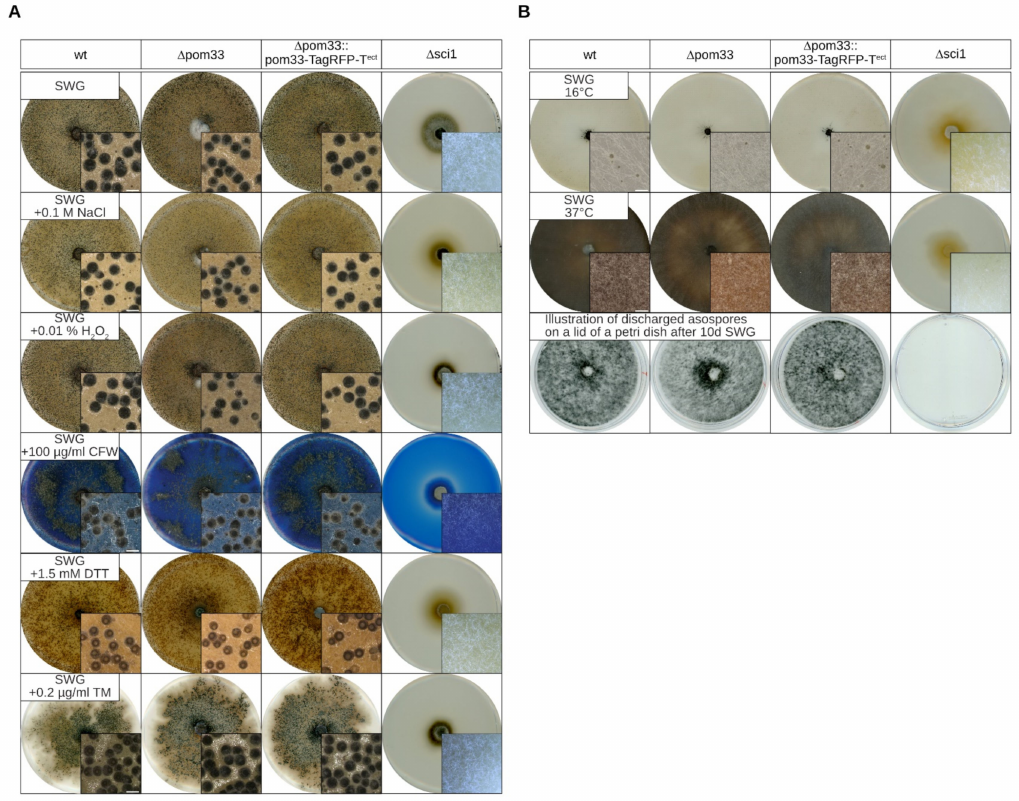
Figure 4. Sexual development in the wt, ∆ pom33, the complementation strain and ∆ sci1 on different stress media. ( A ) The wt, deletion mutant ( ∆ pom33) and the complementation strain ( ∆ pom33::pom33-TagRFP-T ect ) as well as the ∆ sci1 strain were grown in presence of different stress conditions, such as osmotic- (0.1 M NaCl), oxidative- (0.01% H 2 O 2 ), cell wall- (100 µ g/mL CFW), or ER stress (1.5 mM DTT, 0.2 µ g/mL TM) by adding the different components to SWG medium. ( B ) Strains from ( A ) were grown on SWG media at 16 ◦ C and 37 ◦ C to perform temperature stress. After 10 days the lids of petri dishes with discharged ascospores were documented. Here, the spores were already germinated. Pictures of the agar plates and microscopic images of perithecia as shown in the small boxes on the bottom right sides were taken after 8 days. Scale bar of microscopic images: 0.5